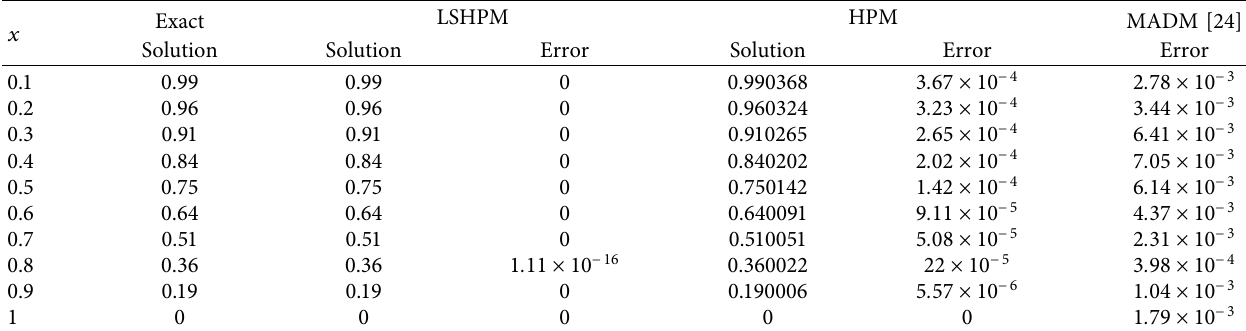
Table 4: Comparison of second-order absolute error of LSHPM with HPM and MADM in Problem 4.